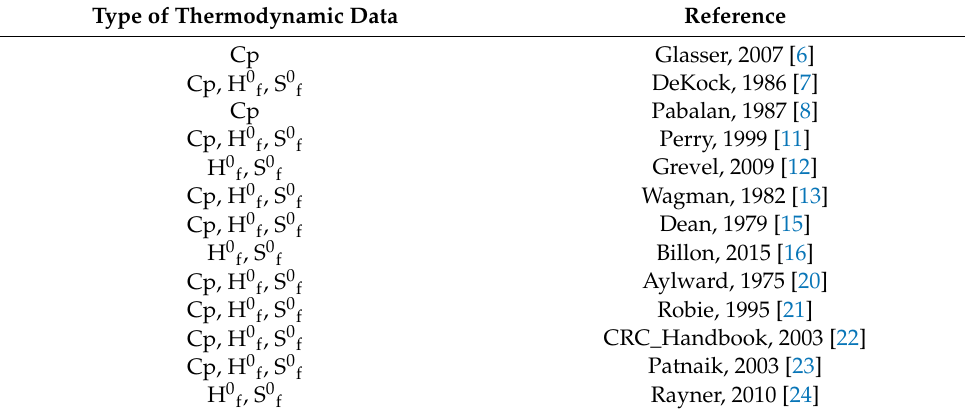
Table 3. Gathered thermodynamic data for MgSO